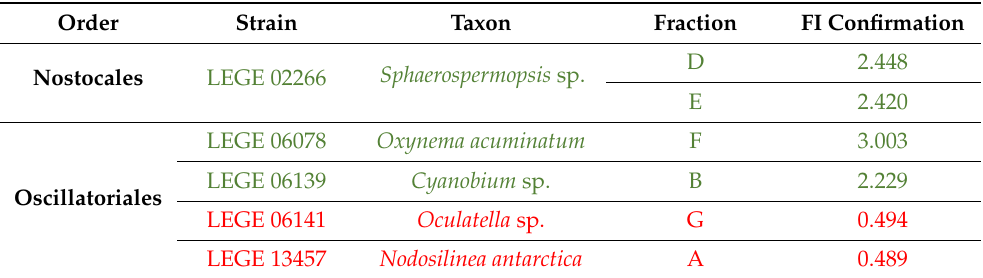
Table 3. Transactivation activity values observed during the secondary screening assays, using cells exposed to fractions of cyanobacteria strains formerly identified as hits in the primary screening, using the mpFN26A[Fluc]/mpGL4.35[Nluc] sensor system in triplex mode. Fold induction (FI) values ≤ 0.5 were considered repressed activity (red), while FI ≥ 2 were considered inducted PPAR activity (green). Dimethyl sulfoxide (DMSO) concentration did not exceed 0.5 % per well. Order Strain Taxon Fraction FI Confirmation Nostocales LEGE 02266 Sphaerospermopsis